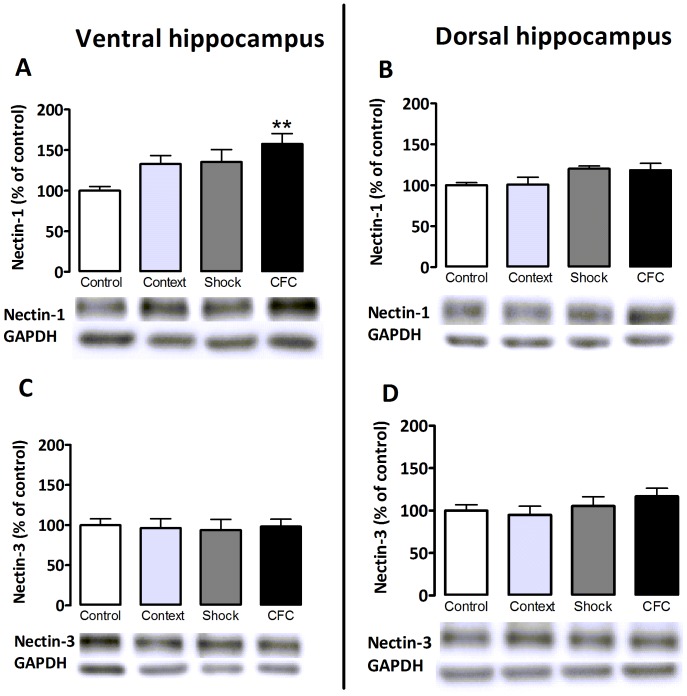
Effect of context, shock and contextual fear conditioning on nectin-1 (A, B) and nectin-3 (C, D) protein expression in synaptic fractions of ventral and dorsal hippocampi.The increase of nectin-1 at 2 h after CFC was not seen after context- or shock exposure alone and was restricted to ventral hippocampus (A). Nectin-1 levels in the dorsal hippocampus were not affected 2 h after shock, context or CFC (B). Nectin-3 levels in both ventral- (C) and dorsal hippocampus (D) were unaffected 2 h after context, shock or CFC. Error bars represent standard error of the mean (n = 7–10 animals/group) (*, p<0.05; ** p<0.01 vs. control group indicated by Bonferroni post hoc test).